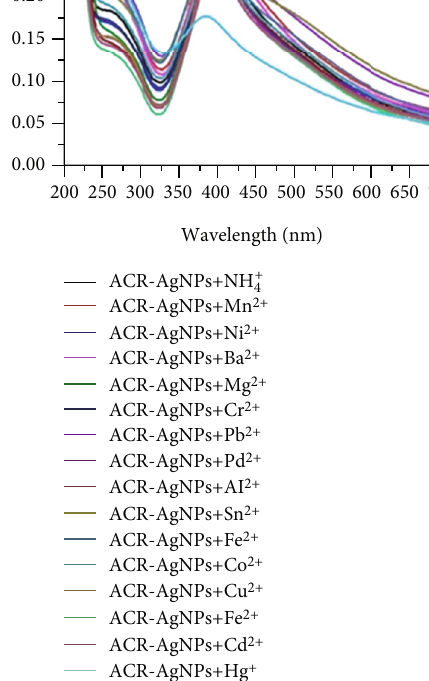
Figure 6: Change in the absorption intensity of ACR-AgNPs upon addition of di ff erent metal cations (100 μ